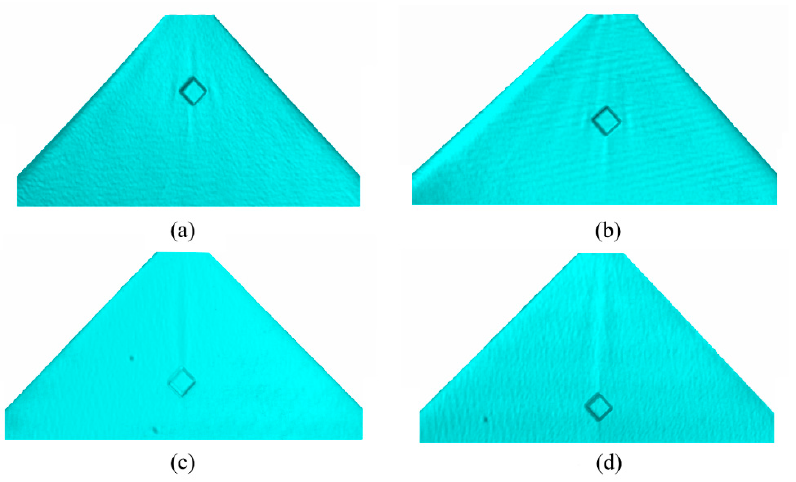
Figure 4. Experimental results of wrinkle patterns of rigid elements on the membrane at different positions: ( a – d ) indicate that the positions R c of the rigid elements are 30 mm, 40 mm, 50 mm, and 60 mm, respectively.